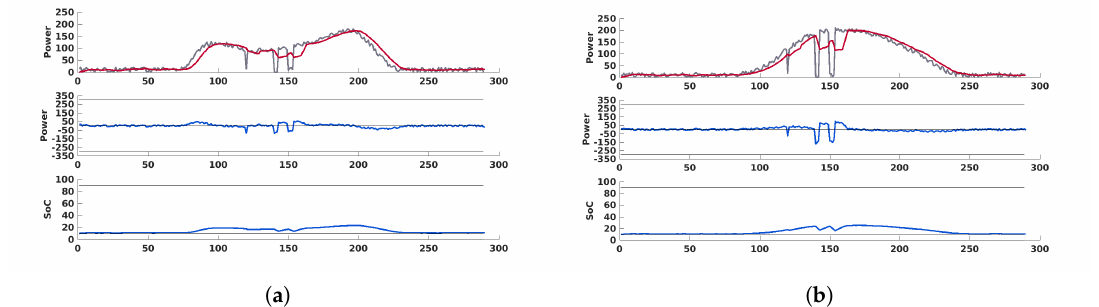
Figure 11. Top: Grid power flow with MA ( P g , red) and without MA ( P hcpv , grey). Middle: Battery power evolution ( P ess , blue) and constraints (grey). Bottom: Battery SoC evolution (blue) and constraints (grey). On a cloudy day case ( a ), on a sunny day ( b ).